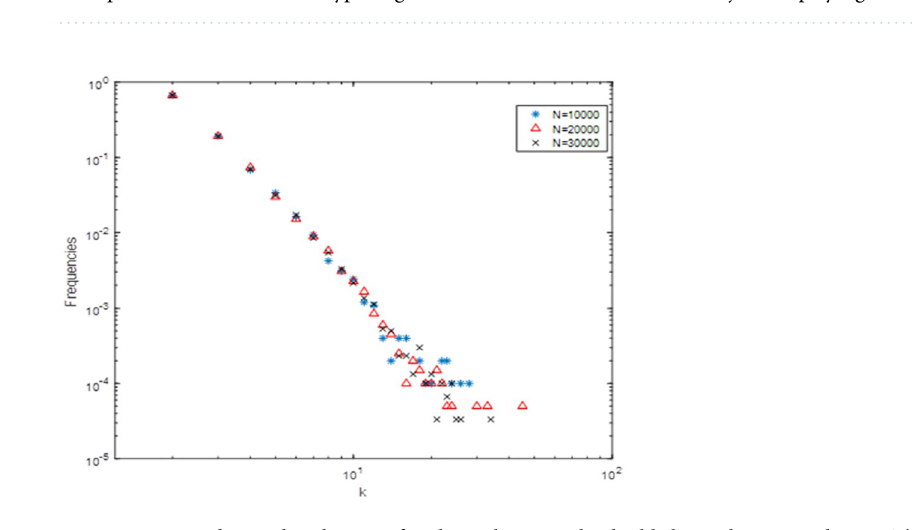
Figure 3. Hyperdegree distribution of nodes is shown in the double logarithmic coordinates. The horizontal coordinate is hyperdegree of nodes, and the vertical coordinate is the frequencies of hyperdegree of nodes occurrence. This figure indicates that nodes with few number of hyperdegree have high frequency, while nodes with more number of hyperdegree have low frequency. The results show that the hypernetwork structure in our model is a scale-free hypernetwork and has the property of the “Matthew